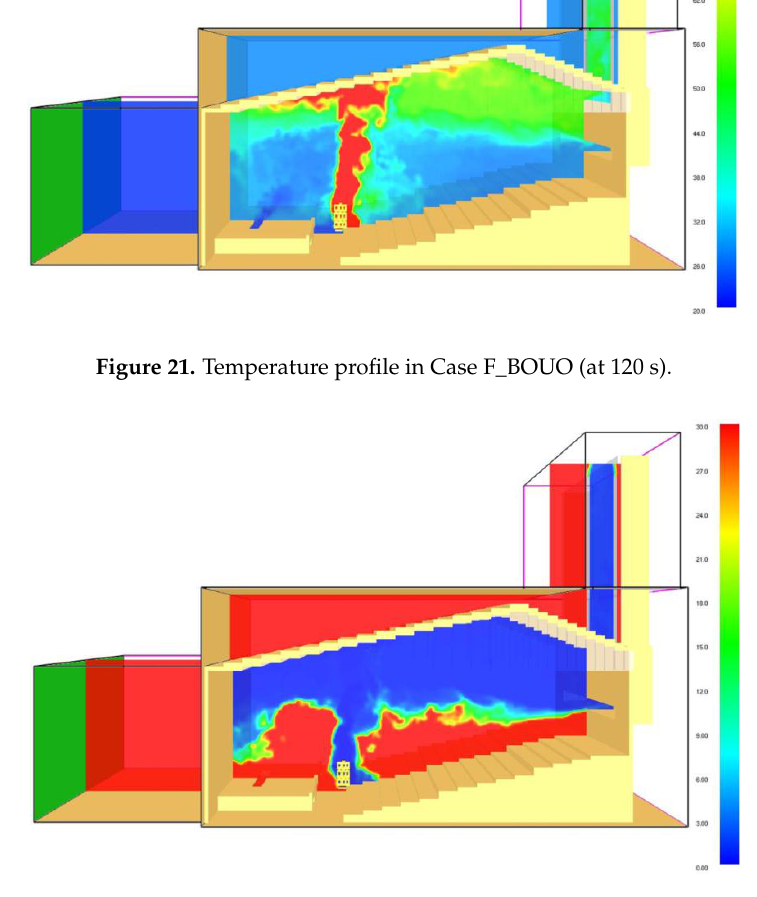
Figure 22. Visibility profile in Case F_ORG (at 120 s).